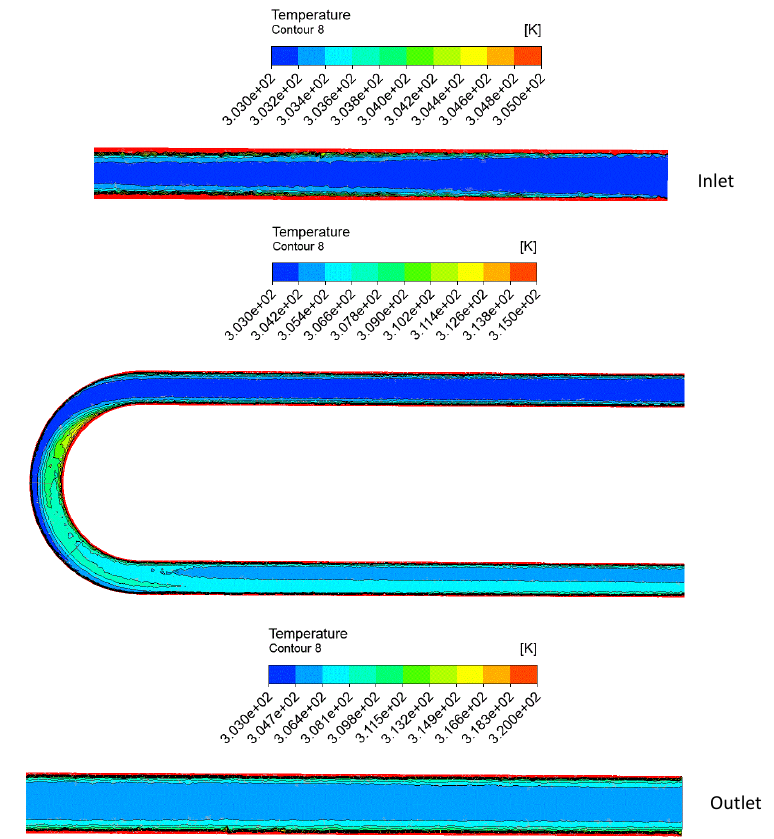
Figure 14. Temperature contour distribution along the computational domain using fruit